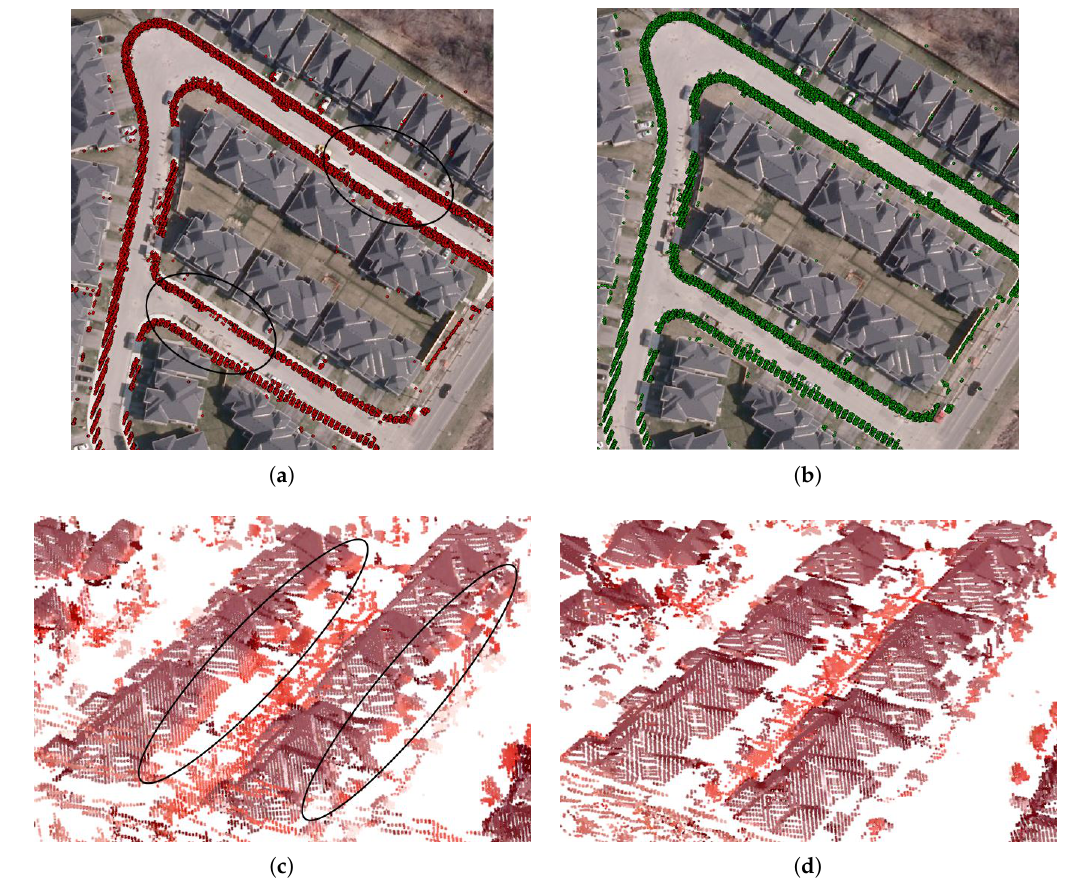
Figure 11. Examples of geo-registration corrections: black ovals represent error locations. ( a ) Sidewalk displacement before corrections: aerial photo as basemap. ( b ) Sidewalk correct positioning: aerial photo as basemap. ( c ) Buildings/grass misalignment before corrections: NIR (Near Infrared), G (Green), and B (Blue) visualization. ( d ) Buildings/grass alignment after corrections: NIR, G, and B